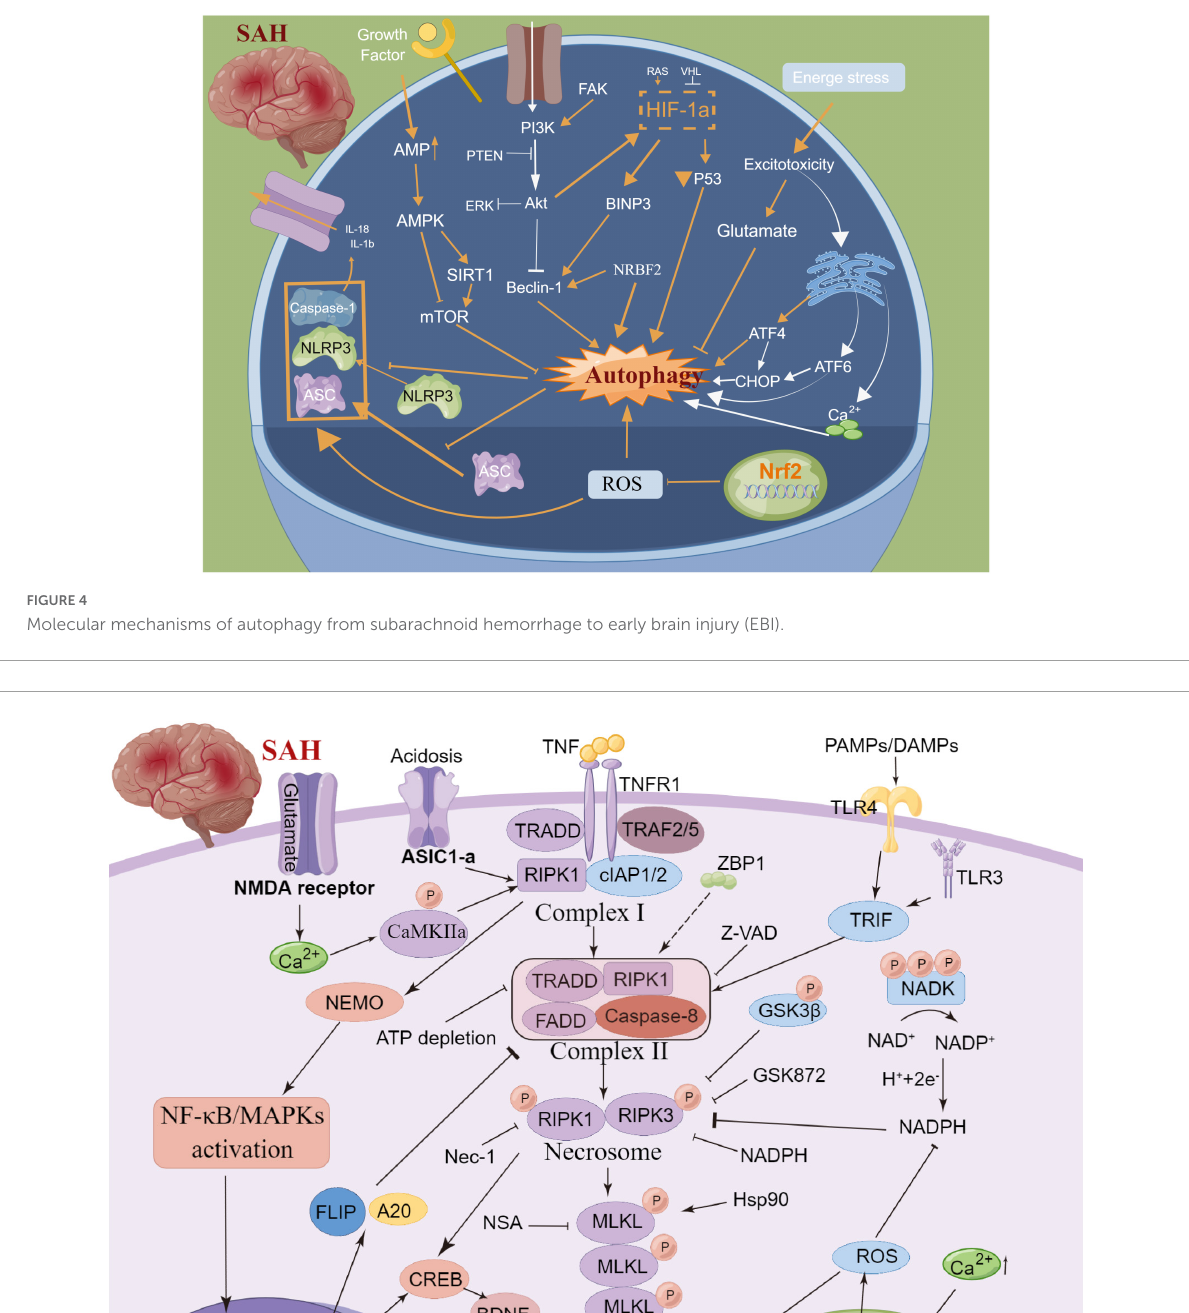
biological characteristics mainly include the metabolic dysfunction of iron ions, depletion of glutathione (GSH), accumulation of iron-dependent lipid reactive oxygen species